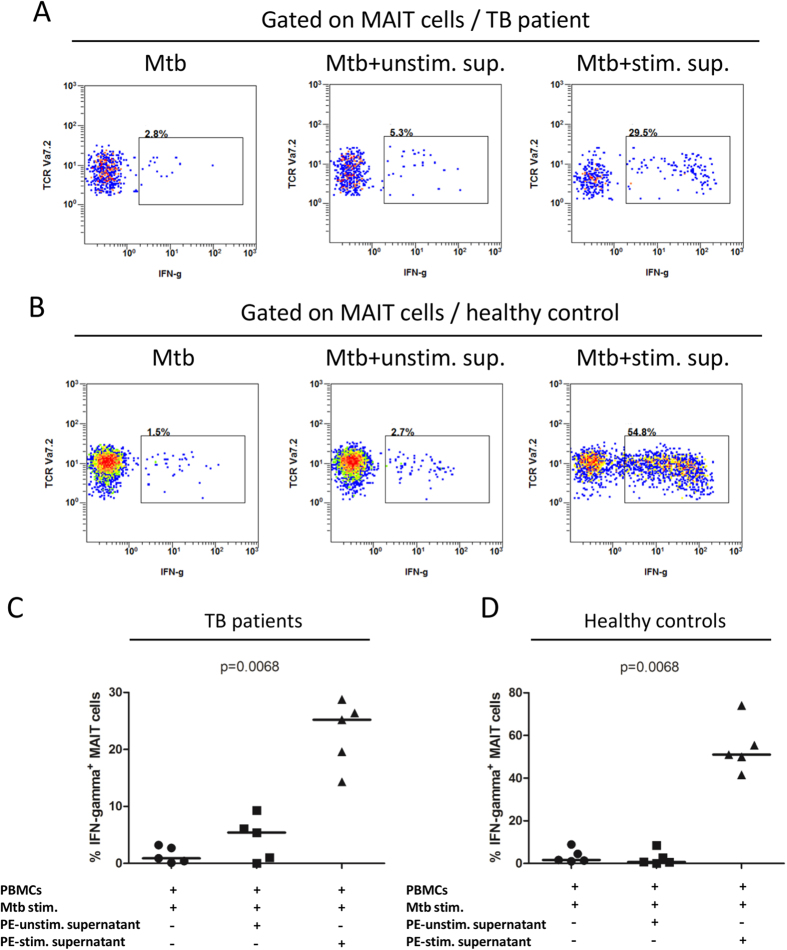
Influence of humoral factors on IFN-γ response of MAIT cells from PBMCs.(A) Representative flow plots showing IFN-γ production in MAIT cells from PBMCs of patient with TB under Mtb stimulation only (Mtb) (left), or with addition of centrifuged supernatant (100 μl) of unstimulated mononuclear cells (Mtb + unstim. sup.) (middle), or supernatants of Mtb-stimulated mononuclear cells from tuberculous pleural effusion (Mtb + stim. sup.) (right). (B) Representative flow plots showing IFN-γ production in MAIT cells from PBMCs of healthy control under same stimulation conditions as stated above. (C) IFN-γ response of MAIT cells in PBMCs from patients with TB (n = 5) under condition of Mtb stimulation alone (Mtb stim.), or with addition of centrifuged supernatants (100 μl) of unstimulated (PE-unstim. supernatant) or Mtb antigen-stimulated cells (PE-stim. supernatant) from tuberculous pleural effusions. (D) Supernatants of Mtb-stimulated cells from tuberculous pleural effusions drove strong IFN-γ response of MAIT cells in PBMCs from healthy controls (n = 5). Horizontal bars in the scatter plots indicate medians. Kruskal-Wallis test was used for statistical analysis among groups.